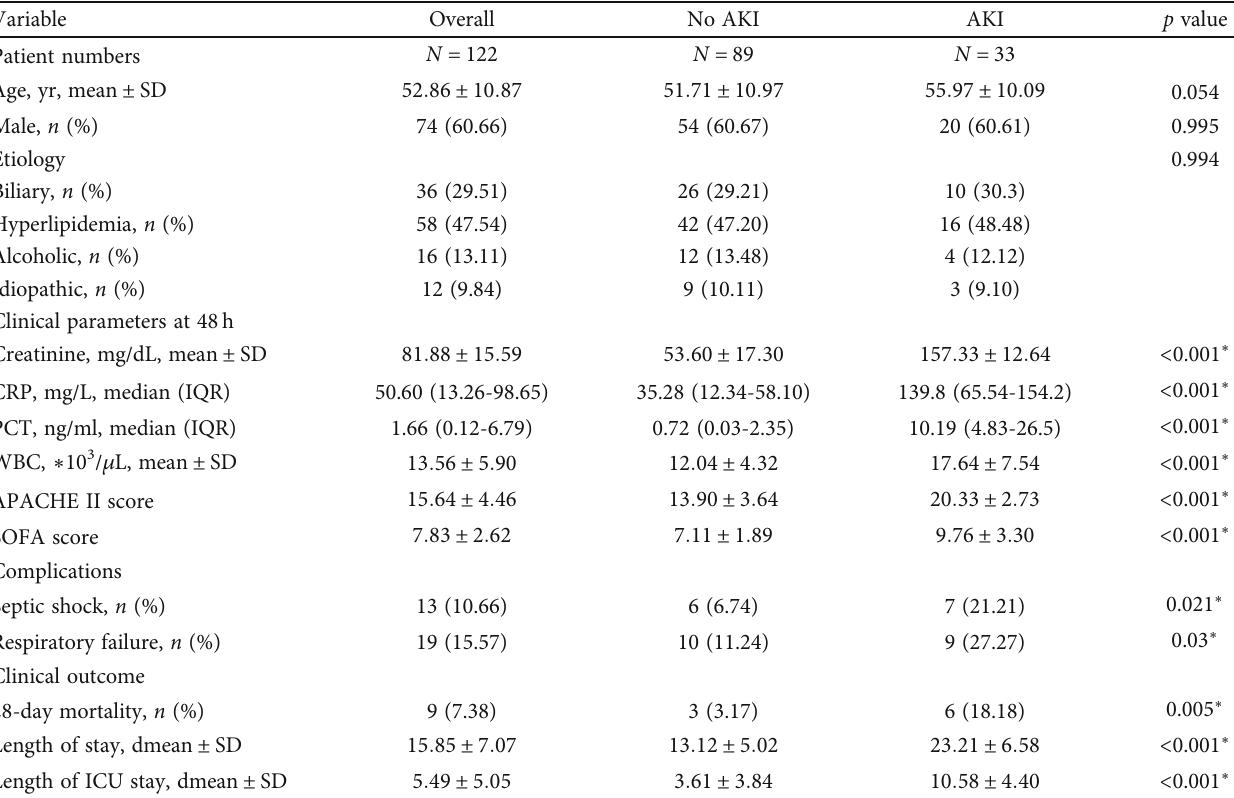
Table 2: Demographic and clinical outcomes of patients classi fi ed by with or without AKI.